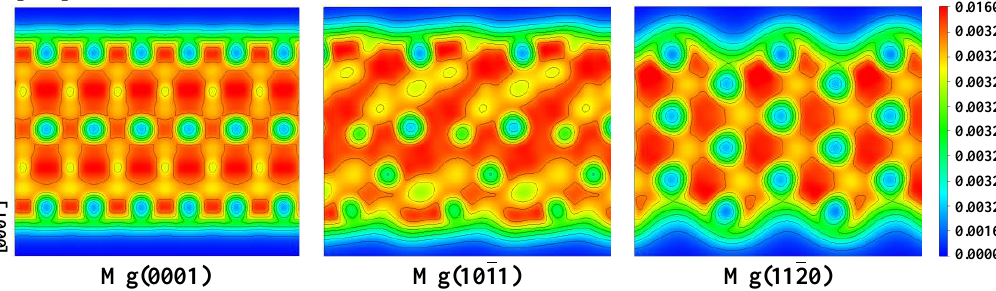
Figure 6. Surface charge density distribution of Mg(0001), Mg(10 1 1) and Mg(11 2 0). To analyze the interaction mechanism of RGD on the Mg(11 2 0) and Mg(10 1 1) sur- faces, the changes of electronic structures (see Figures 7 and 8) were investigated through PDOS, and the charge density difference ( ∆ ρ ) was calculated by Equation (4). It should be pointed out that the interaction mechanism of RGD on the Mg(0001) was proposed by our previous paper [17].